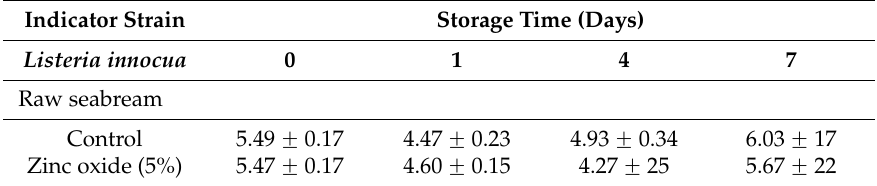
Table 2. Survival of Listeria innocua CECT 4032 inoculated on seabream slices vacuum-packaged in low density polyethylene films activated or not with 5% zinc oxide. Samples were stored at 4 ˝ C for 7